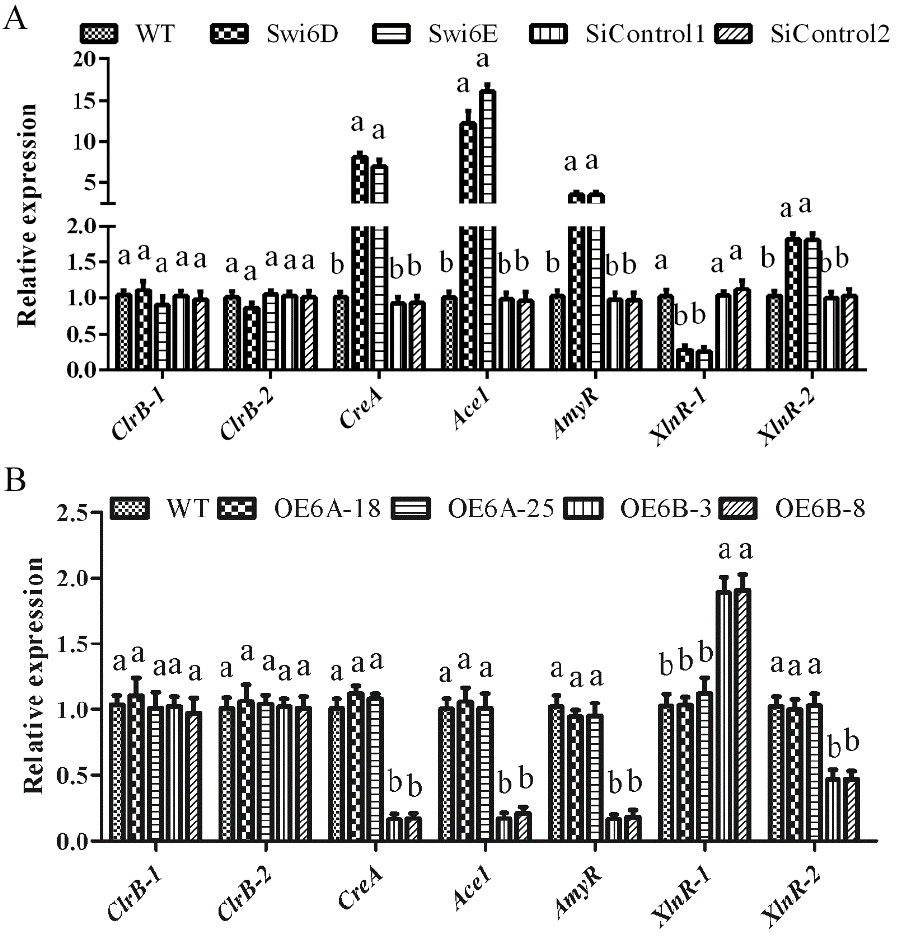
Figure 2. GlSwi6 is involved in regulating the expression of cellulase and xylanase regulator genes. G. lucidum cultured in CYM liquid medium for 5 days was transferred to MCM medium using cellulose as the sole carbon source for 24 h. ( A ) The expression of cellulase and xylanase regulator genes in GlSwi6-silenced strains. ( B ) The expression of cellulase and xylanase regulator genes in GlSwi6 overexpression strains. The values are the mean ± SE ( n = 3). Different letters indicate significant differences between the strains ( p < 0.05, Tukey′s test).